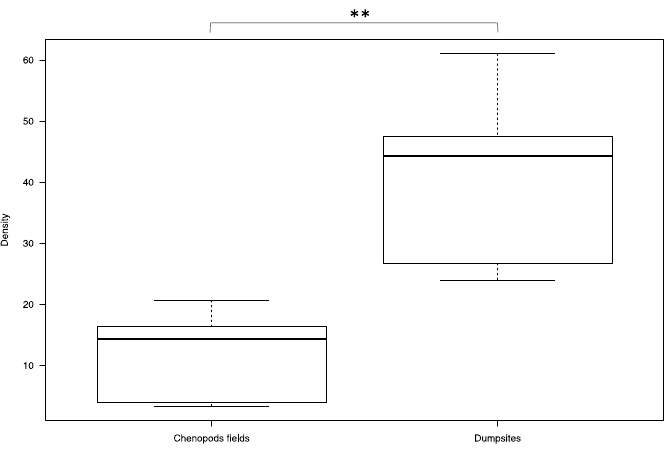
Figure 6. Overall densities of Phlebotomus papatasi in the chenopod fields and in the dumpsites adjacent to the village of Ouled Mohamed. (The thick black line represents the median. Lower and upper lines represent the first and third quartile, respectively. Whiskers show the minimum and maximum values. Significance: ** < 0.01.)